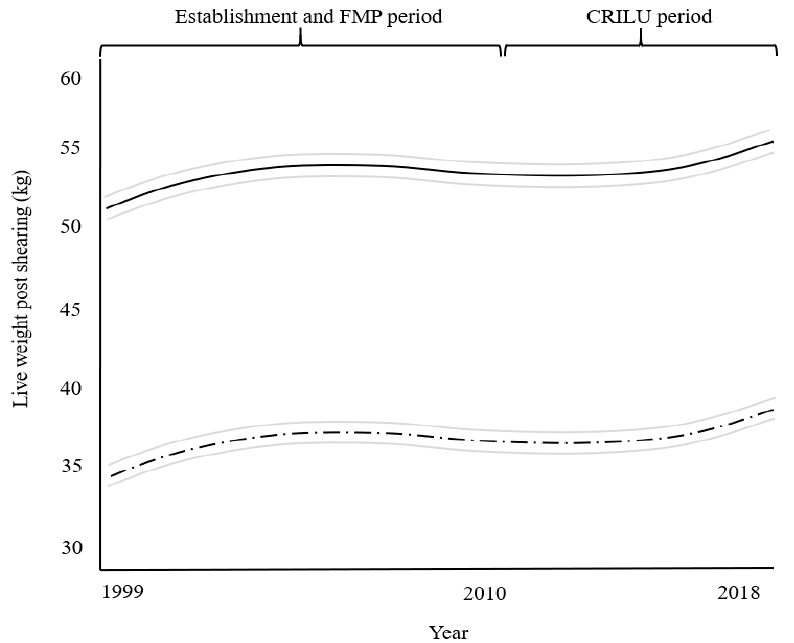
Figure 3. Male (solid line) and female (non-solid line) phenotype trends using a third-degree poly- nomial regression model for live weight post-shearing (321 to 438 days) across the entire study period (1999–2018). The light gray lines represent the 95% confidence limits. R 2 for the combined (male and female), male and female models were 0.69, 0.23 and 0.25, respectively.